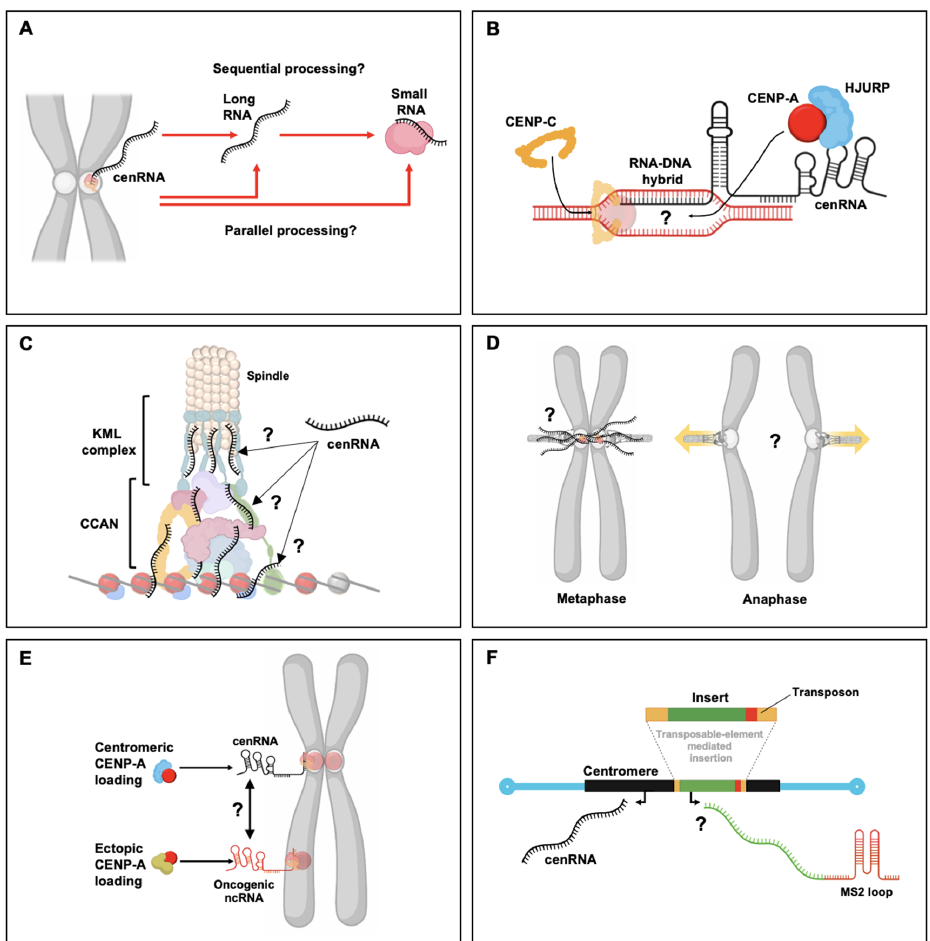
Figure 3. Open questions about the functional consequences of centromeric transcription. ( A ) Even though two different types of RNAs are produced from the centromere, namely, lncRNAs and small RNAs, it remains unclear whether these two types of RNAs are produced sequentially or in parallel. ( B ) Both CENP-A and CENP-B associate with centromeric transcripts and both CENP-A loading and CENP-C loading have been linked to RNA–DNA triplex formation. Additionally, in maize, CENP-C binding to centromeric DNA is associated with small RNA, whereas in humans CENP-A loading has been tied to lncRNAs. It remains unclear whether the same transcript can recruit and stabilize both CENP-A and CENP-C at centromeric chromatin. ( C ) As CENP-A and CENP-C loading is cenRNA-dependent, one intriguing question is whether the kinetochore structure as a whole is dependent on the presence of centromeric transcripts. If so, which kinetochore components drive this dependence? ( D ) The localization and activity of CPC at the inner centromere are dependent on centromeric transcripts. It will be of great interest to understand how mitotic pulling forces modulate centromeric transcription, especially during the transition from metaphase to anaphase. ( E ) CENP-A nucleosomes have been found both at the centromere and ectopically. Especially in cancers, ectopic CENP-A accumulates. Little sequenceconservationexistsbetweenectopicCENP-Asites andthecentromere. Thisleaves the possibility that specific secondary and tertiary RNA structures exist that are found similar to / in common between transcripts derived from the centromere and ectopic sites, allowing ectopic sites to hijack CENP-A recruitment. In addition, this might also provide critical insights into the evolution of centromere DNA from a functional perspective as a CENP-A recruitment motif. ( F ) Whereas various loci on the chromosome arms have been extensively studied using genetics tools such as LacO operons and MS2 / PP7 stem-loops, the centromere has been recalcitrant to genetic manipulations because of its highly repetitive nature. In Arabidopsis thaliana , the A. lyrate Tal1 LTR retrotransposon specifically integrates into the A. thaliana centromere. This opens the door to finally genetically modify the centromere to be able to study transcription in an inducible and tractable manner, and recruit proteins of